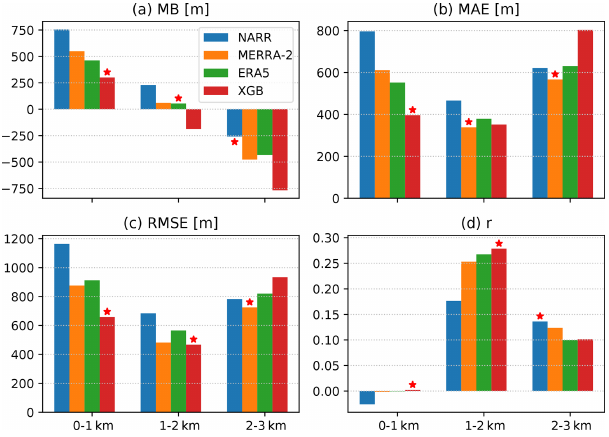
Figure 7. Agreements between CALIPSO-retrieved PBLH and spa- tiotemporally co-located PBLH from NARR, MERRA-2, ERA5, and the XGB prediction. The CALIPSO dataset was split into ranges of 0–1, 1–2, and 2–3km, corresponding to the three clusters of bars in each panel. The evaluation metrics include the mean bias (MB) (a) , MAE (b) , RMSE (c) , and the Pearson correlation coeffi- cient (d) . The red star labels the dataset with the closest